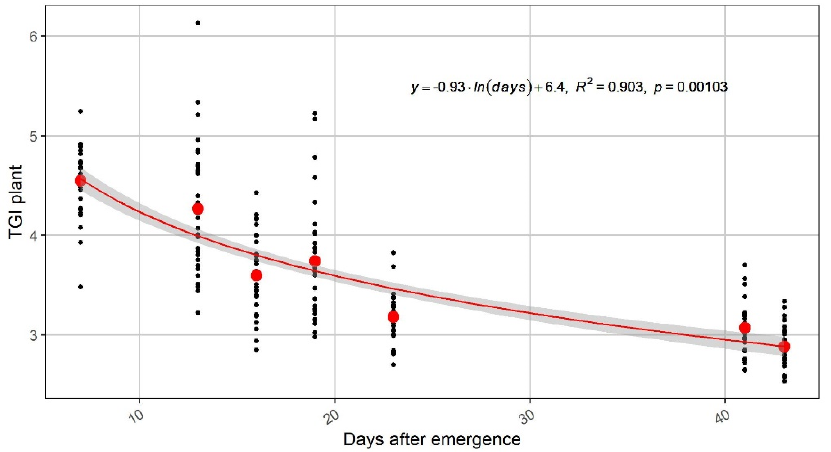
Figure 8. Relationship between the TGI of plants measured by imaging with an RGB camera and time 198 (days after germination) in a field experiment conducted with water yam (cv C18) in Tieningboué 199 (Côte d’Ivoire) with different fertilizations and rotations. Each dot represents the value per plant and 200 red dots represent the average values for all 32 plants. The grey band indicates the 95% confidence 201 interval. 202 The SPAD values measured on 14 July and 8 and 10 August 2018 on diagnostic leaves was negatively correlated to the TGI values measured at plant level (Figure 9; Table S6), whereas no relation was observed between TGI and leaf N content, or SPAD and leaf N content measured on 8 and 10 August